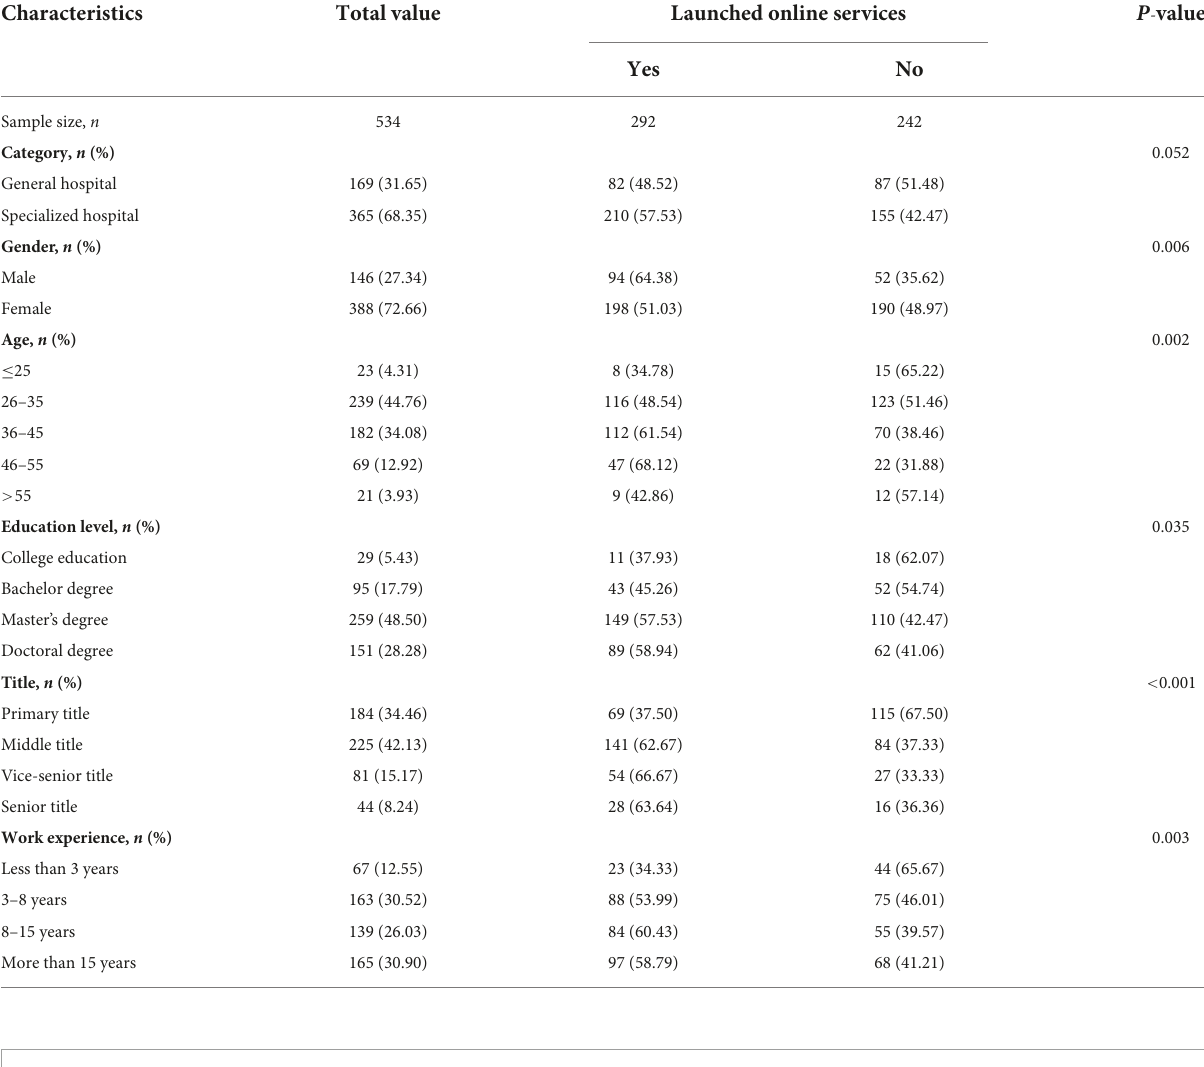
TABLE 3 Current usage of internet hospitals by study participants ( N = 534).